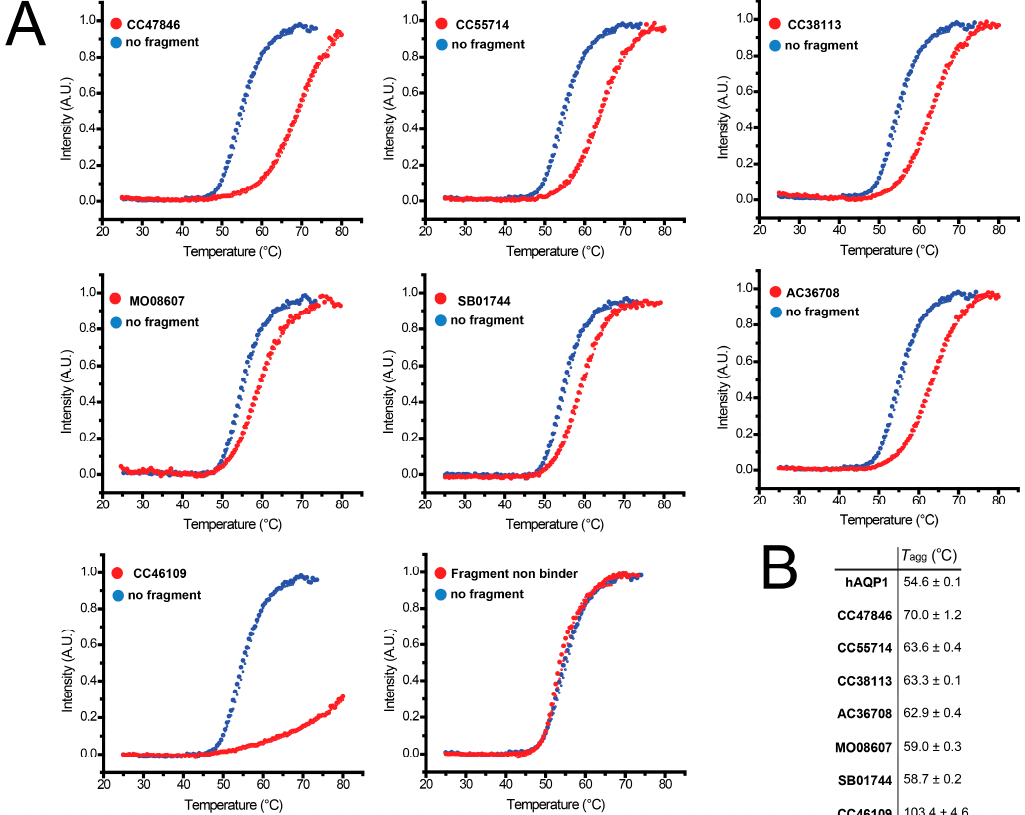
Figure 7. Thermal denaturation curves of hAQP1. ( A ) assays performed in the presence of 1 mM of each of the seven stabilizing hit fragments shown in ( B ). Light scattering intensities are plotted as a function of temperature and fitted to the Boltzmann equation by non-linear regression to obtain the temperature of aggregation, T agg . Each curve is a representative of three independent experiments with similar results; ( B ) average T agg values of purified hAQP1 in the absence and presence of hit fragments.